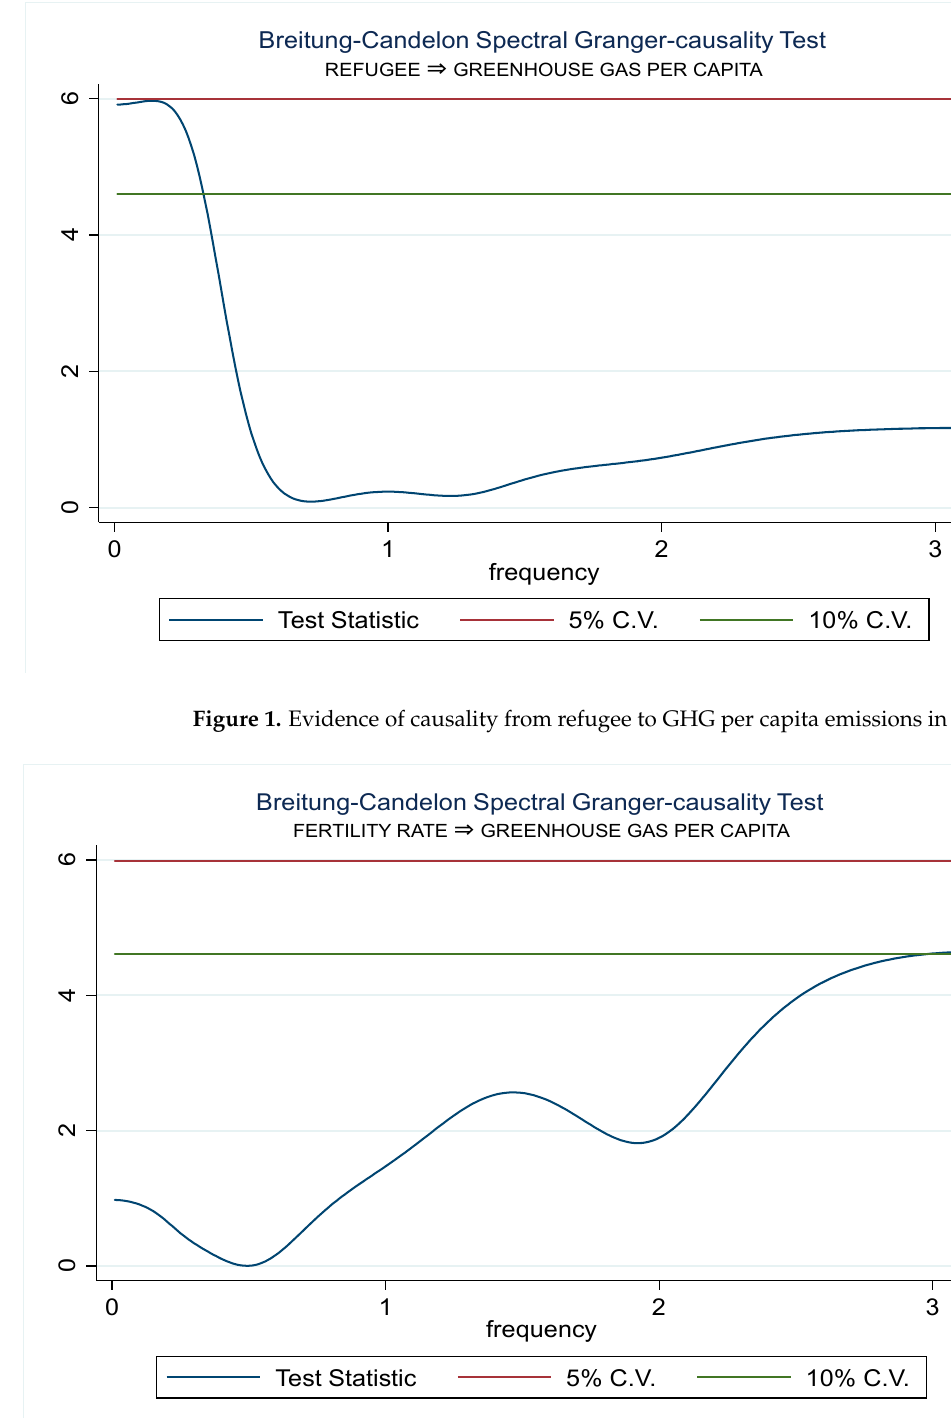
Figure 2. Evidence of causality from fertility rate to GHG per capita emissions in Lebanon.